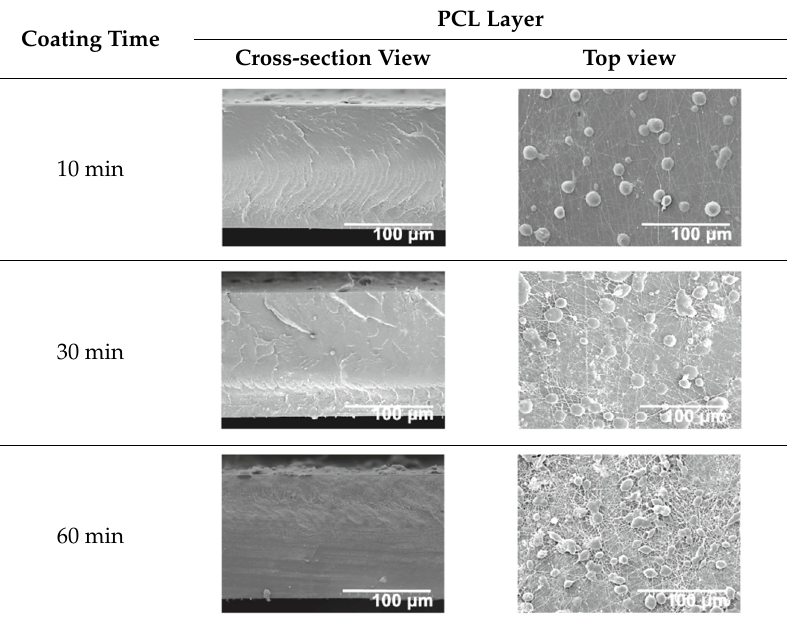
Table 4. Apparent water contact angles of the nanostructured multilayer films of low-density polyethylene (LDPE) coated with electrospun ultrathin poly( ε -caprolactone) (PCL) fibers and electrosprayed silica (SiO 2 ) microparticles with varied PCL deposition times. *: The SiO 2 microparticles were deposited for 1 h for all the samples. **: The thermal treatment was 55 °C for 1 min. Values are reported as means ± standard deviations.